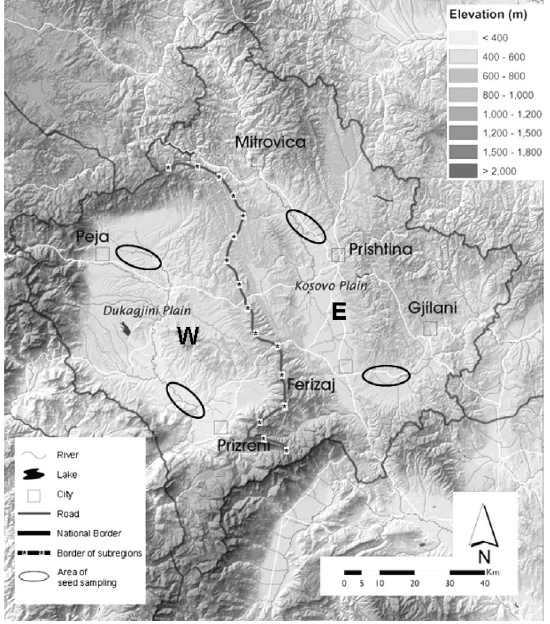
Figure 1. Areas of seed collection in two sub-regions W and E of